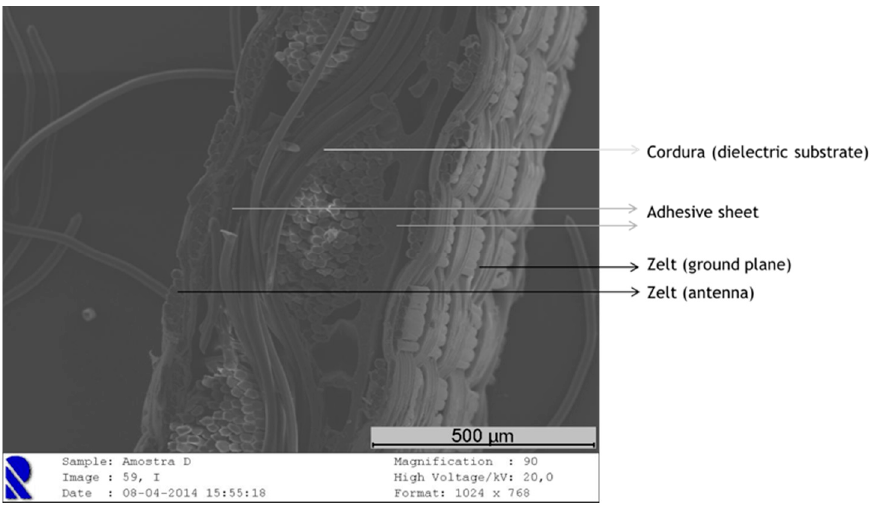
Figure 5. SEM image: cross-section of the textile antenna after assembly with adhesive sheet, without steam.